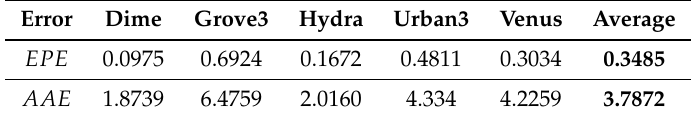
Table 8. Results obtained by the uniform matching location strategy in VALIDATION_SET.